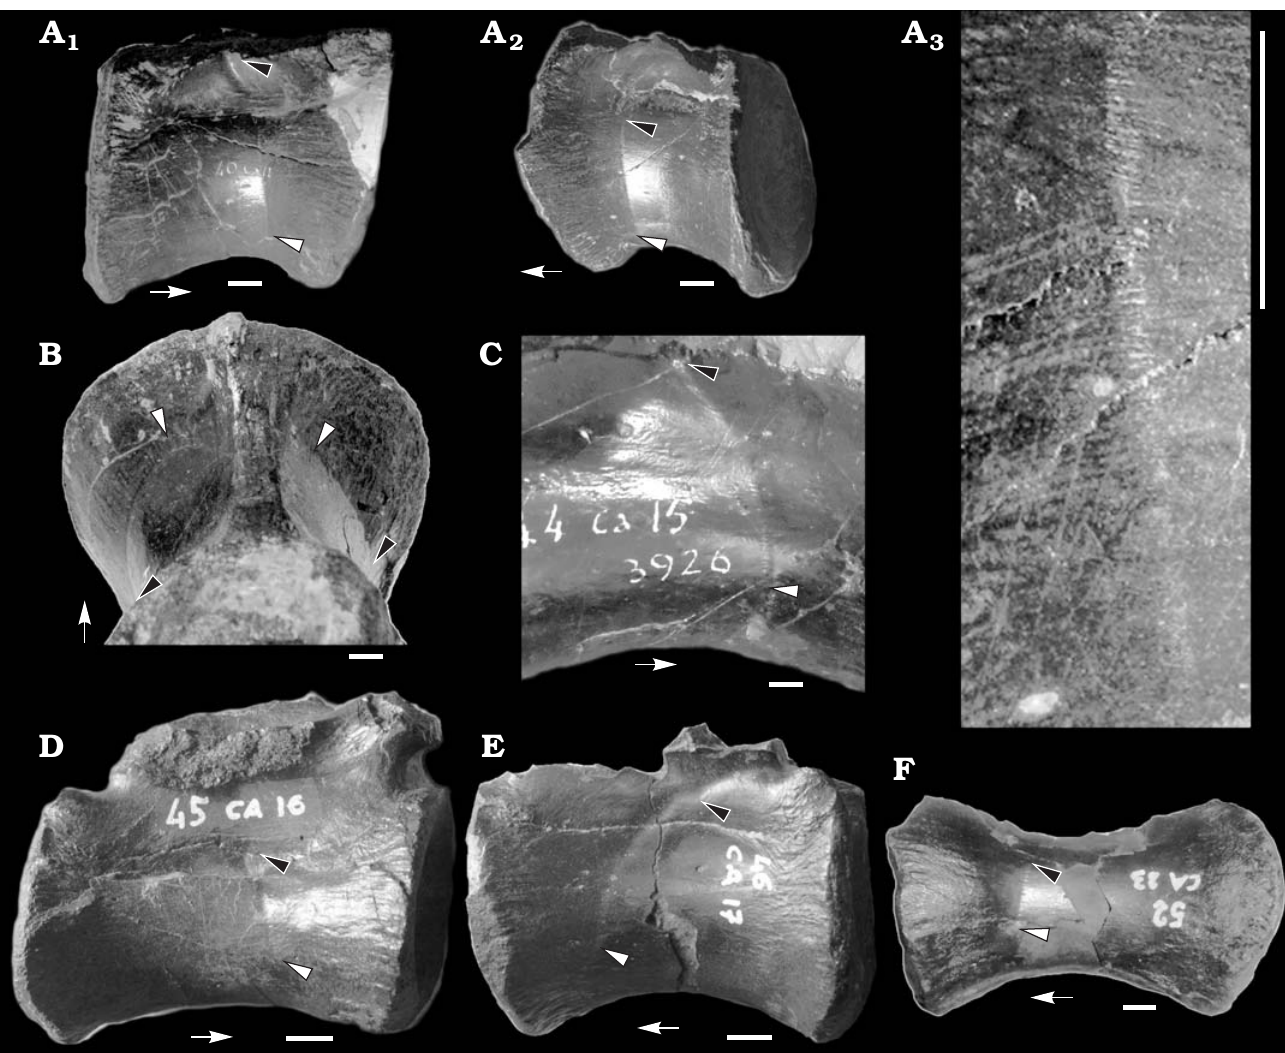
Fig. 1. Caudal vertebrae of the theropod dinosaur Allosaurus fragilis Marsh, 1877 from Cleveland Lloyd Quarry of Utah (USA), Morrison Formation, Kimmeridgian–Tithonian. A . MUP 40CA11, ~10 th –13 th position, in right lateral (A ). B . MUP 41CA12 2744, ~9 th –12 th position. C . MUP 44CA15 3926, ~14 th –17 th position. D . MUP 45CA16, ~14 th –18 th position. E . MUP 46CA17, (A 3 ~16 th –20 th position. F . MUP 52CA23 (~21 st –24 th position). In lateral (A, C–F) and posteroventral (B) views. Black arrowheads indicate dorsalmost extent of CFL (caudofemoralis longus muscle) sucus, white arrowheads indicate ventralmost extent of CFL sulcus, arrows point toward anterior end of vertebra. Scale bars 10